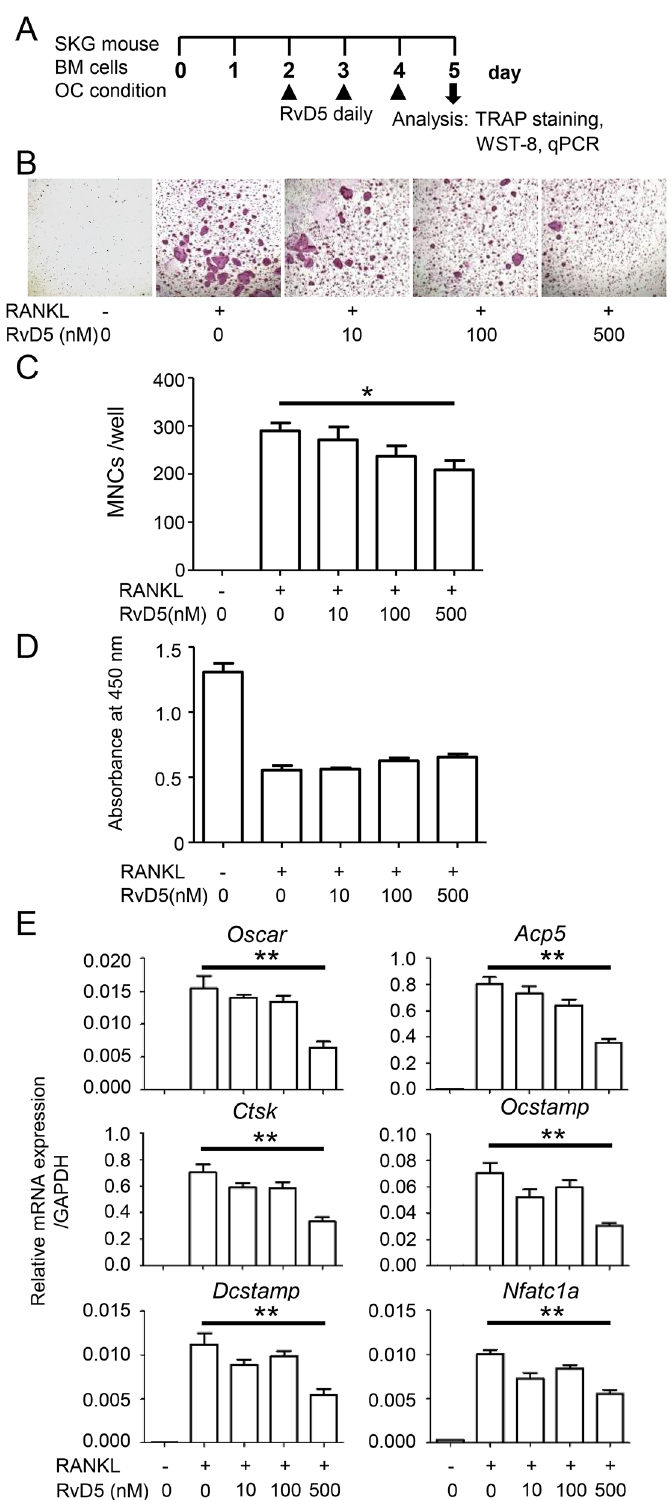
Figure 4. RvD5 suppresses RANKL-induced osteoclastogenesis. ( A ) Schematic representation of RANKL- induced osteoclastogenesis. BM cells were isolated from 8–10-week-old SKG mice and cultured for 2 days with M-CSF. BMMs were then incubated with M-CSF and RANKL, with or without daily RvD5 (10–500 nM). Cells were fixed and stained for TRAP after 5 days of culture. ( B ) Representative images of TRAP staining. ( C ) TRAP- positive MNCs were counted. ( D ) Relative cell viability. ( E ) The mRNA expression levels were quantified by qPCR. Messenger RNA levels were normalized to GAPDH. Bars represent mean ± SEM. ** P < 0.01, by one-way analysis of variance and Tukey’s multiple comparison